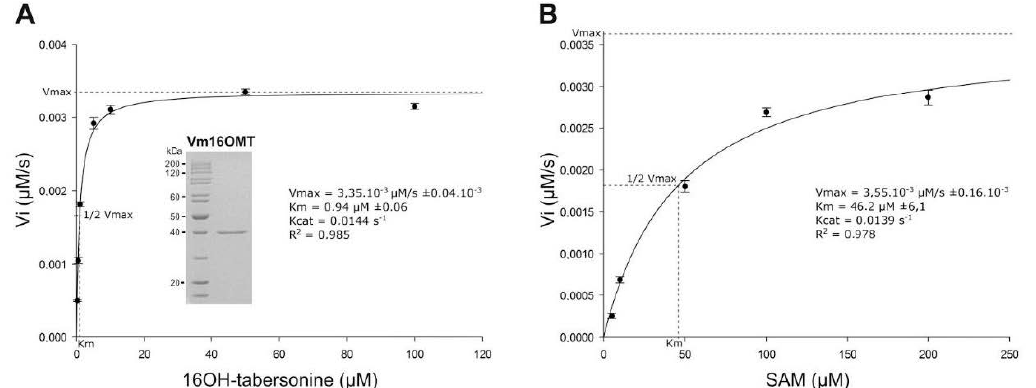
Figure 8. Determination of Vm16OMT kinetic parameters for 16-hydroxytabersonine ( A ) and SAM ( B ). Vm16OMT initial velocities in 16-methoxytabersonine synthesis were measured using fixed SAM concentration and from 0.2 to 100 µM 16-hydroxytabersonine ( A ) or fixed 16-hydroxytabersonine concentration and from 1 to 200 µM SAM ( B ). Nonlinear regressions based on the Michaelis–Menten equation were applied to estimate kinetic parameters. Purity of the recombinant Vm16OMT used was controlled on acrylamide gel stained with Coomassie blue ( A ) Error bars correspond to standard deviation of biological replicates ( n = 4).